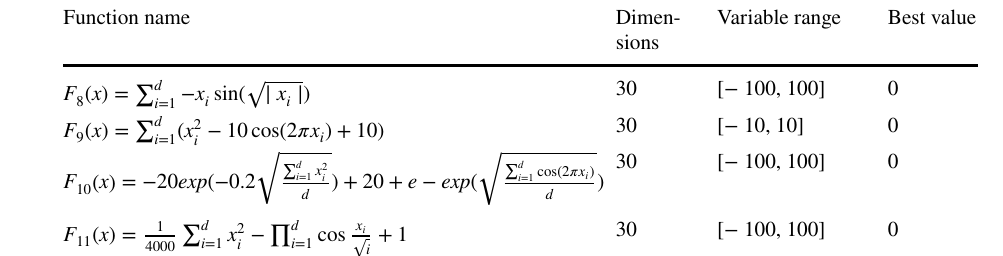
Table 2 Multi-dimensional multi-peak test function